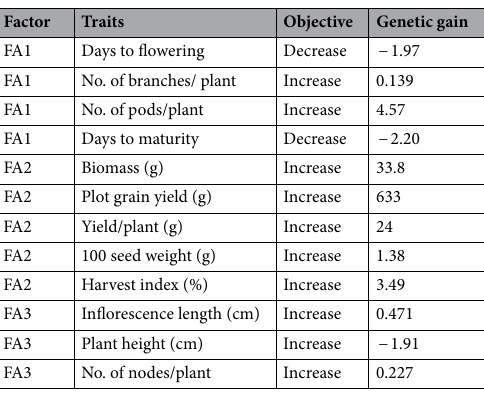
Table 5. Genetic gain for different traits based on MGIDI Index.